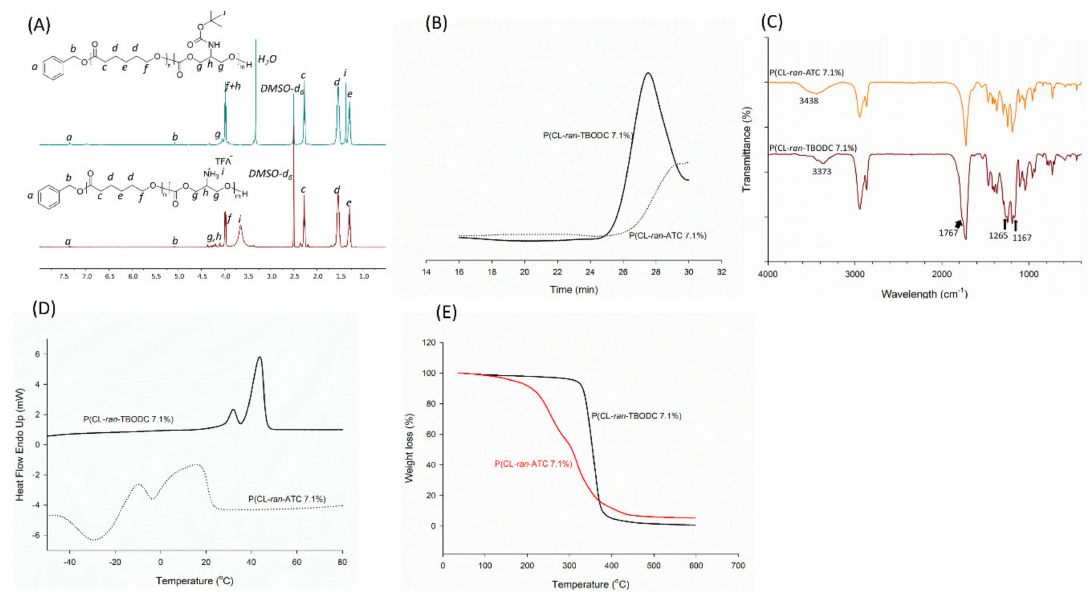
Figure 3. ( A ) 1 H NMR spectra of P(CL- ran -ATC 7.1%) and P(CL- ran -TBODC 7.1%) (DMSO- d 6 , 400 MHz); ( B ) GPC curves of P(CL- ran -ATC 7.1%) and P(CL- ran -TBODC 7.1%); ( C ) FT-IR spectra of P(CL- ran -ATC 7.1%) and P(CL- ran -TBODC 7.1%); ( D ) DSC traces of P(CL- ran -ATC 7.1%) and P(CL- ran -TBODC 7.1%); ( E ) TGA traces of P(CL- ran -ATC 7.1%) and P(CL- ran -TBODC